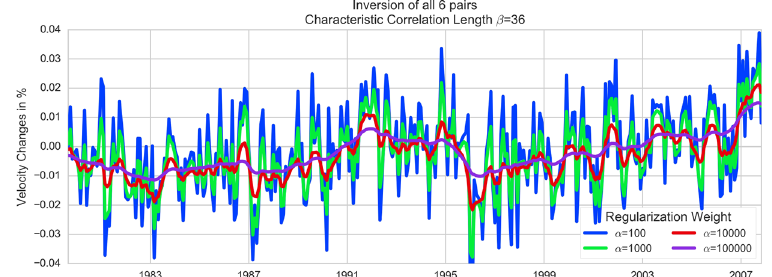
Figure 9. The result of the dv/v inversion for different regularization (smoothing) parameters α